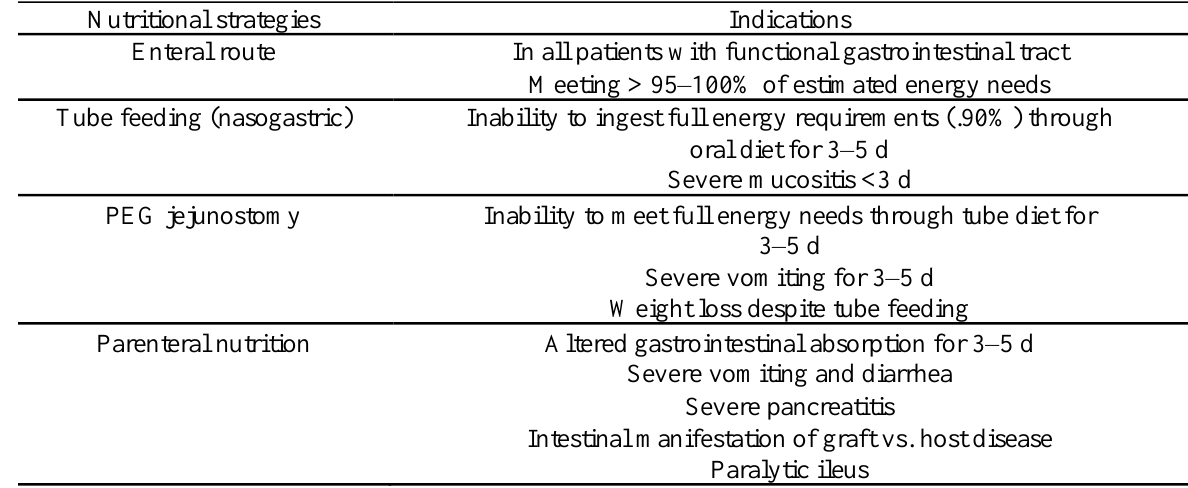
Table 4. Nutritional strategies for children with cancer. Adapted from Bauer et al.